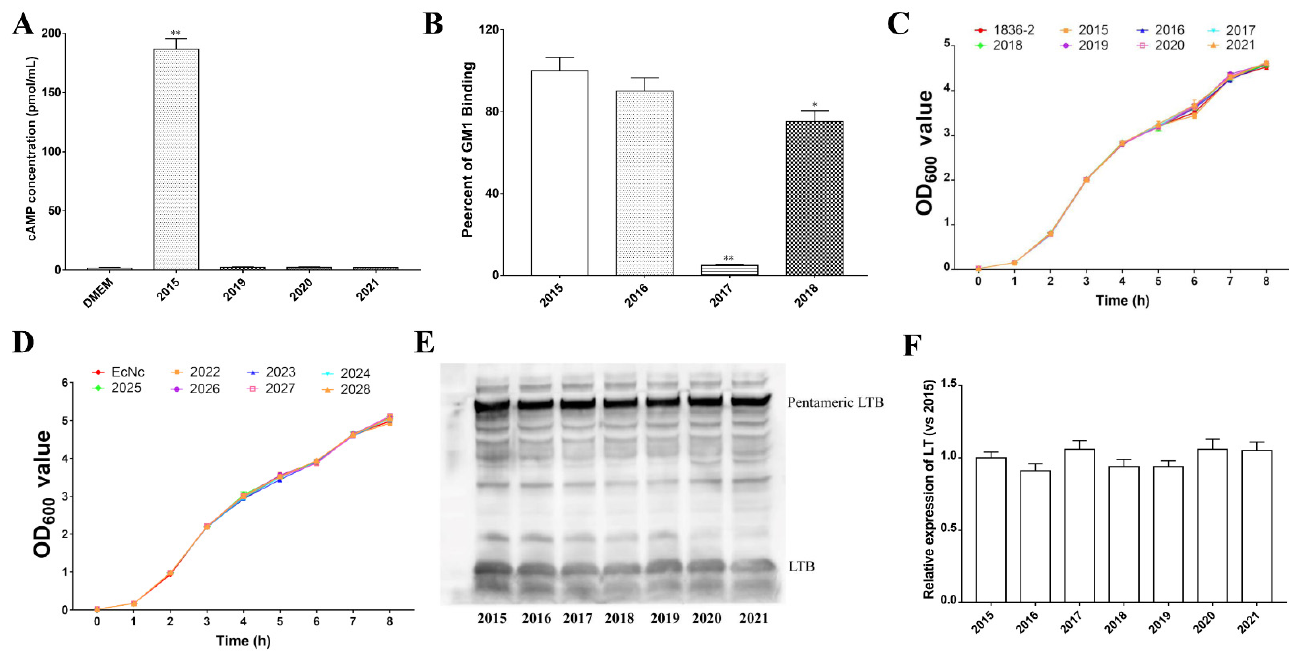
Figure 1. Characterization of native LT and its mutants. ( A ) The intracellular levels of cAMP induced by 2015 (1836-2/pLT), 2019 (1836-2/pLTA R192G ), 2020 (1836-2/pLTA L211A ), and 2021 (1836- 2/pLTA R192G/L211A ) strains following incubation with IPEC-J2 cells. The intracellular level of cAMP from IPEC-J2 cells using just incubation with DMEM medium used as the negative control. ( B ) The GM1-binding activity of the culture medium from 2015, 2016 (1836-2/pLTB Q3K ), 2017 (1836- 2/pLTB G33S ), and 2018 (1836-2/pLTB T47A ) strains. The GM1-binding activity of the culture medium from 2015 strain was presented as 100%. Data are expressed as the mean ± standard deviation (SD) of triplicate independent experiments. ( C ) Growth curves for E. coli strains 1836-2, 2015, 2016, 2017,